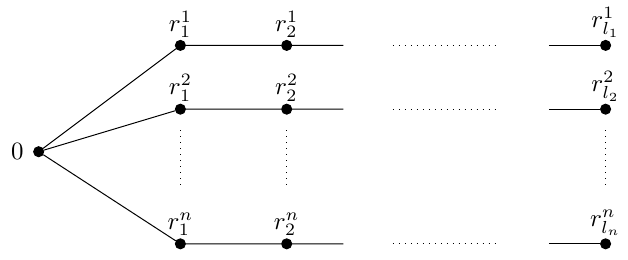
Figure 21 . Plumbing tree for a general Seifert